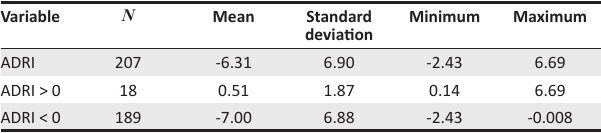
TABLE 4: Summary statistics for the agricultural drought resilience index for the Frances Baard District Municipality.